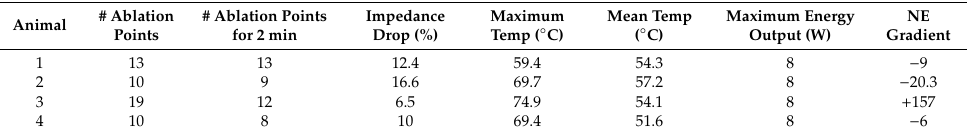
Table 2. Procedural characteristics in denervated